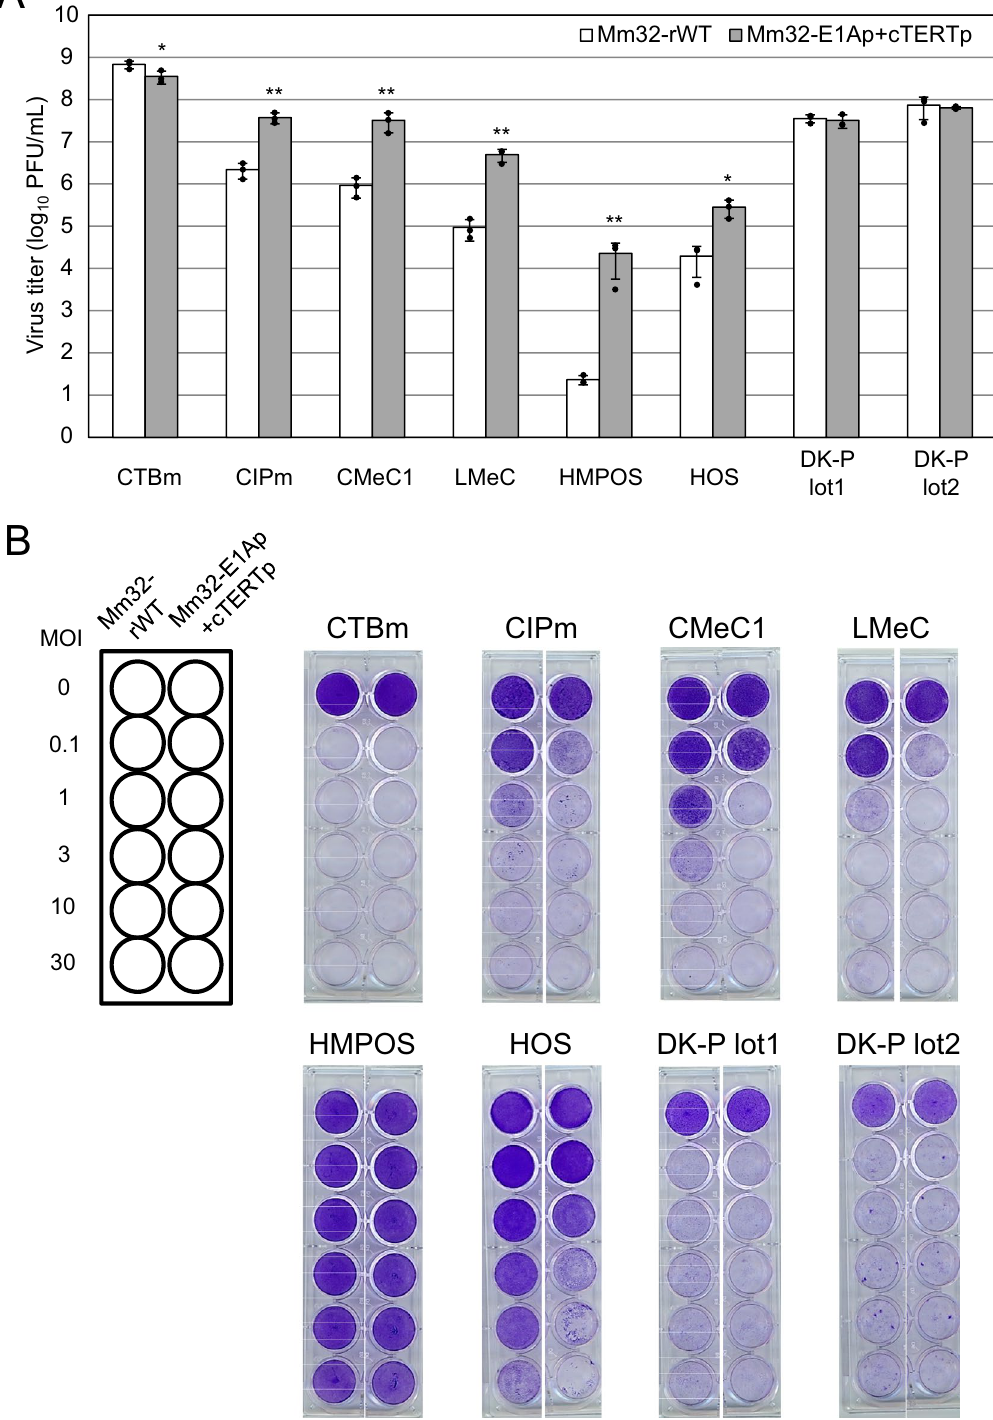
Figure 5. Growth and cytotoxicity of Mm32-rWT and Mm32-E1Ap + cTERTp in canine tumor cells. ( A ) Canine tumor cells (CTBm, CIPm, CMeC1, LMeC, HMPOS, and HOS) and canine kidney-derived normal cells (DK-P lot1 and DK-P lot2) were infected with Mm32-rWT or Mm32-E1Ap + cTERTp at an MOI of 0.1, respectively. At 3 days post-infection, the medium and cells were frozen and thawed three times, and the supernatants were collected. Viral titers were determined by plaque assay using MDCK-Mm32-E1-28 cells. The results are reported as the mean titers with standard errors of the mean for three independent experiments (with scatter plot of three values). The asterisks indicate significant differences (*p < 0.05; **p < 0.01 by Student’s t-test). ( B ) Canine tumor cells and normal canine cells were infected with Mm32-rWT or Mm32-E1Ap + cTERTp at an MOI of 0.1, 1, 3, 10, or 30. At 5 days post-infection, the cells were fixed with methanol and stained with 0.1% crystal